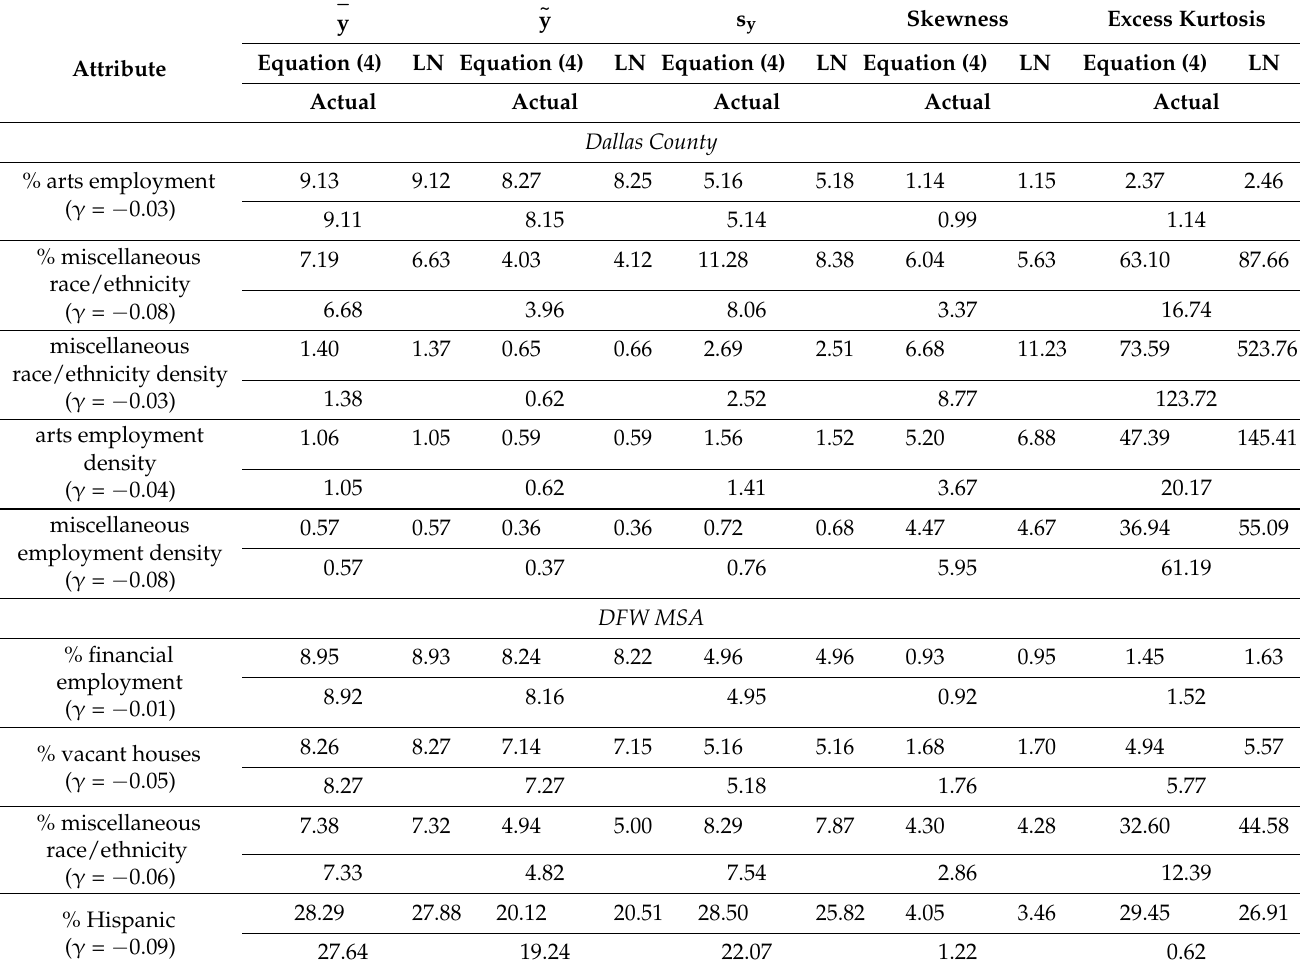
Table 10. Equation (4) and Box–Cox LN specimen attribute back-transformation